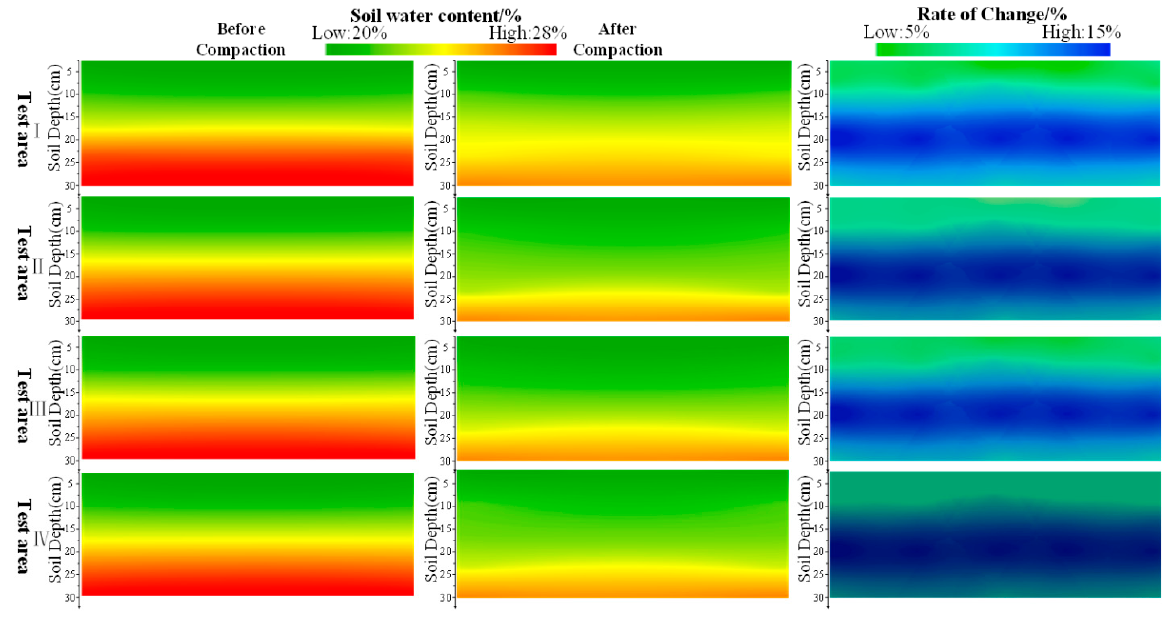
Figure 5. Longitudinal spatial semi − variance function of soil water content in each test area.